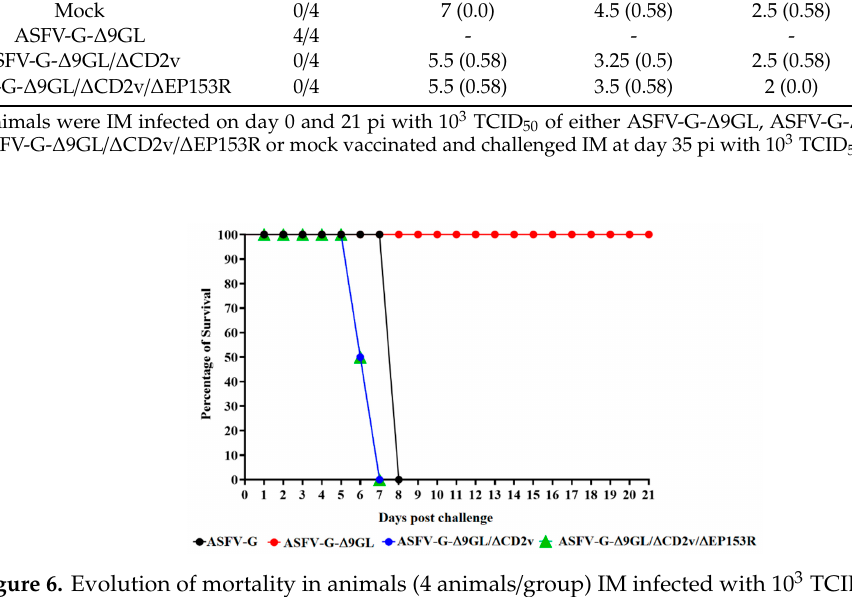
Figure 6. Evolution of mortality in animals (4 animals / group) IM infected with 10 3 TCID 50 of either ASFV-G- ∆ 9GL, ASFV-G- ∆ 9GL / ∆ CD2v, or ASFV-G- ∆ 9GL / ∆ CD2v / ∆ EP153R and challenged IM with 10 3 TCID 50 of either ASFV-G. Comparison between the survival curves produced by groups of pigs infected with different viruses were assessed by the Log-rank (Mantel–Cox). Analysis was conducted on Graphpad Prism software version 8.2.1.